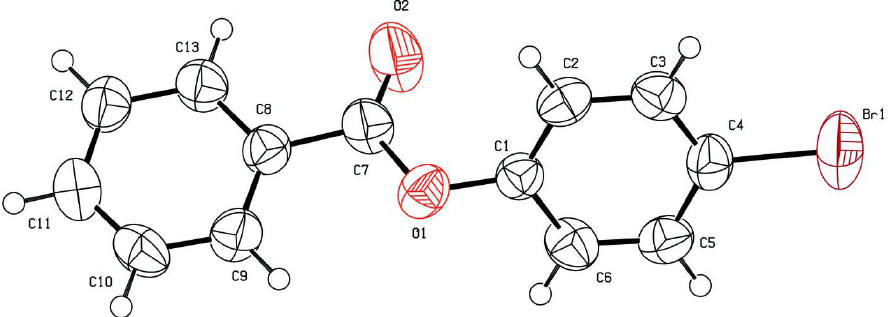
Molecular structure of the title compound, showing the atom labeling. Displacement ellipsoids are drawn at the 50% probability